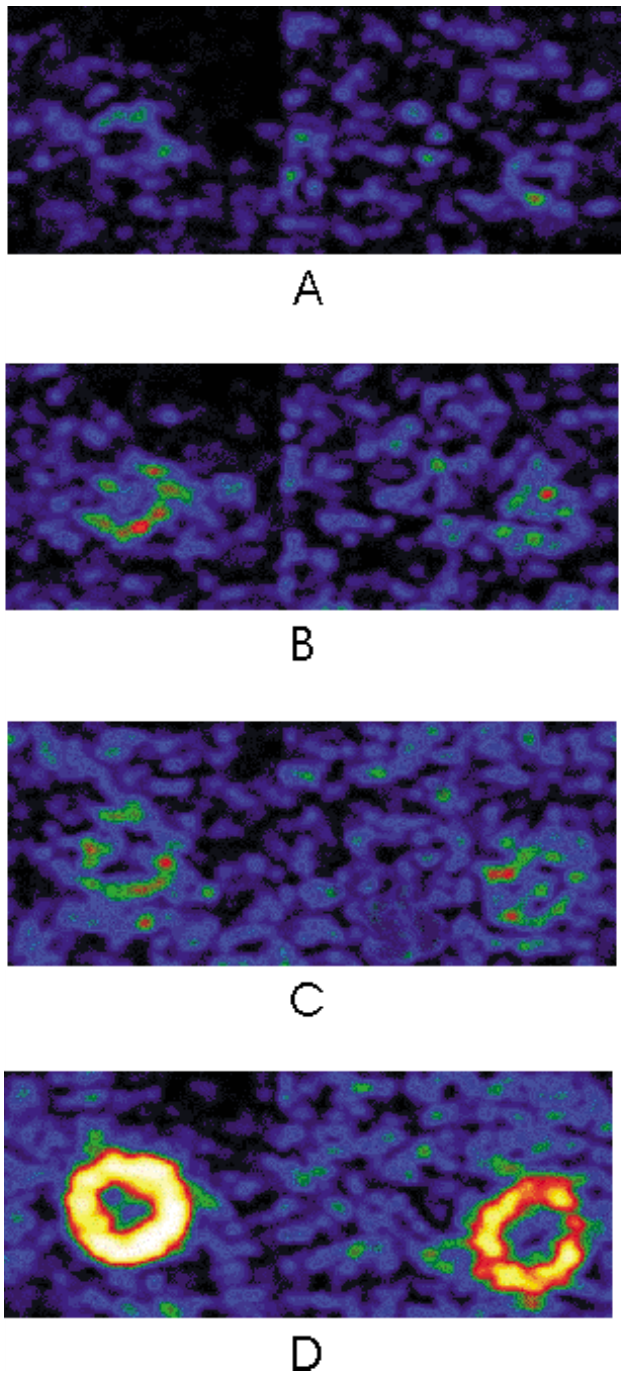
Fig. 4A, B, C and D – From the same original 20 average frames, another sequence of difference frames were taken, using a time interval of 1.5 seconds to show the slow increase in time/space of the blue